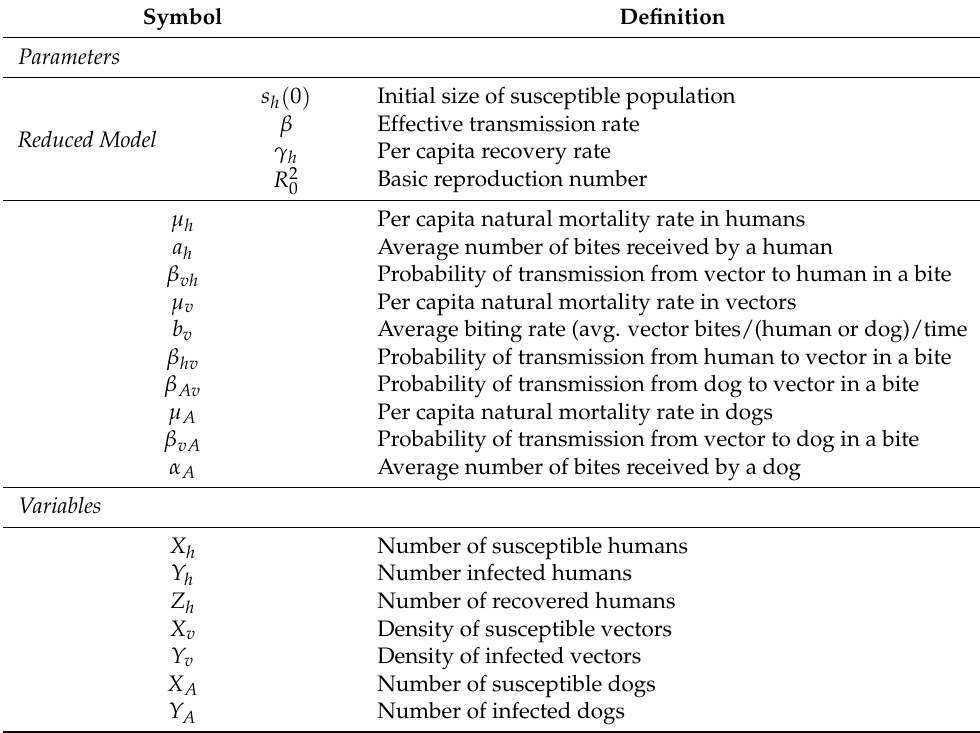
Table 2. Variables and parameters of model used for